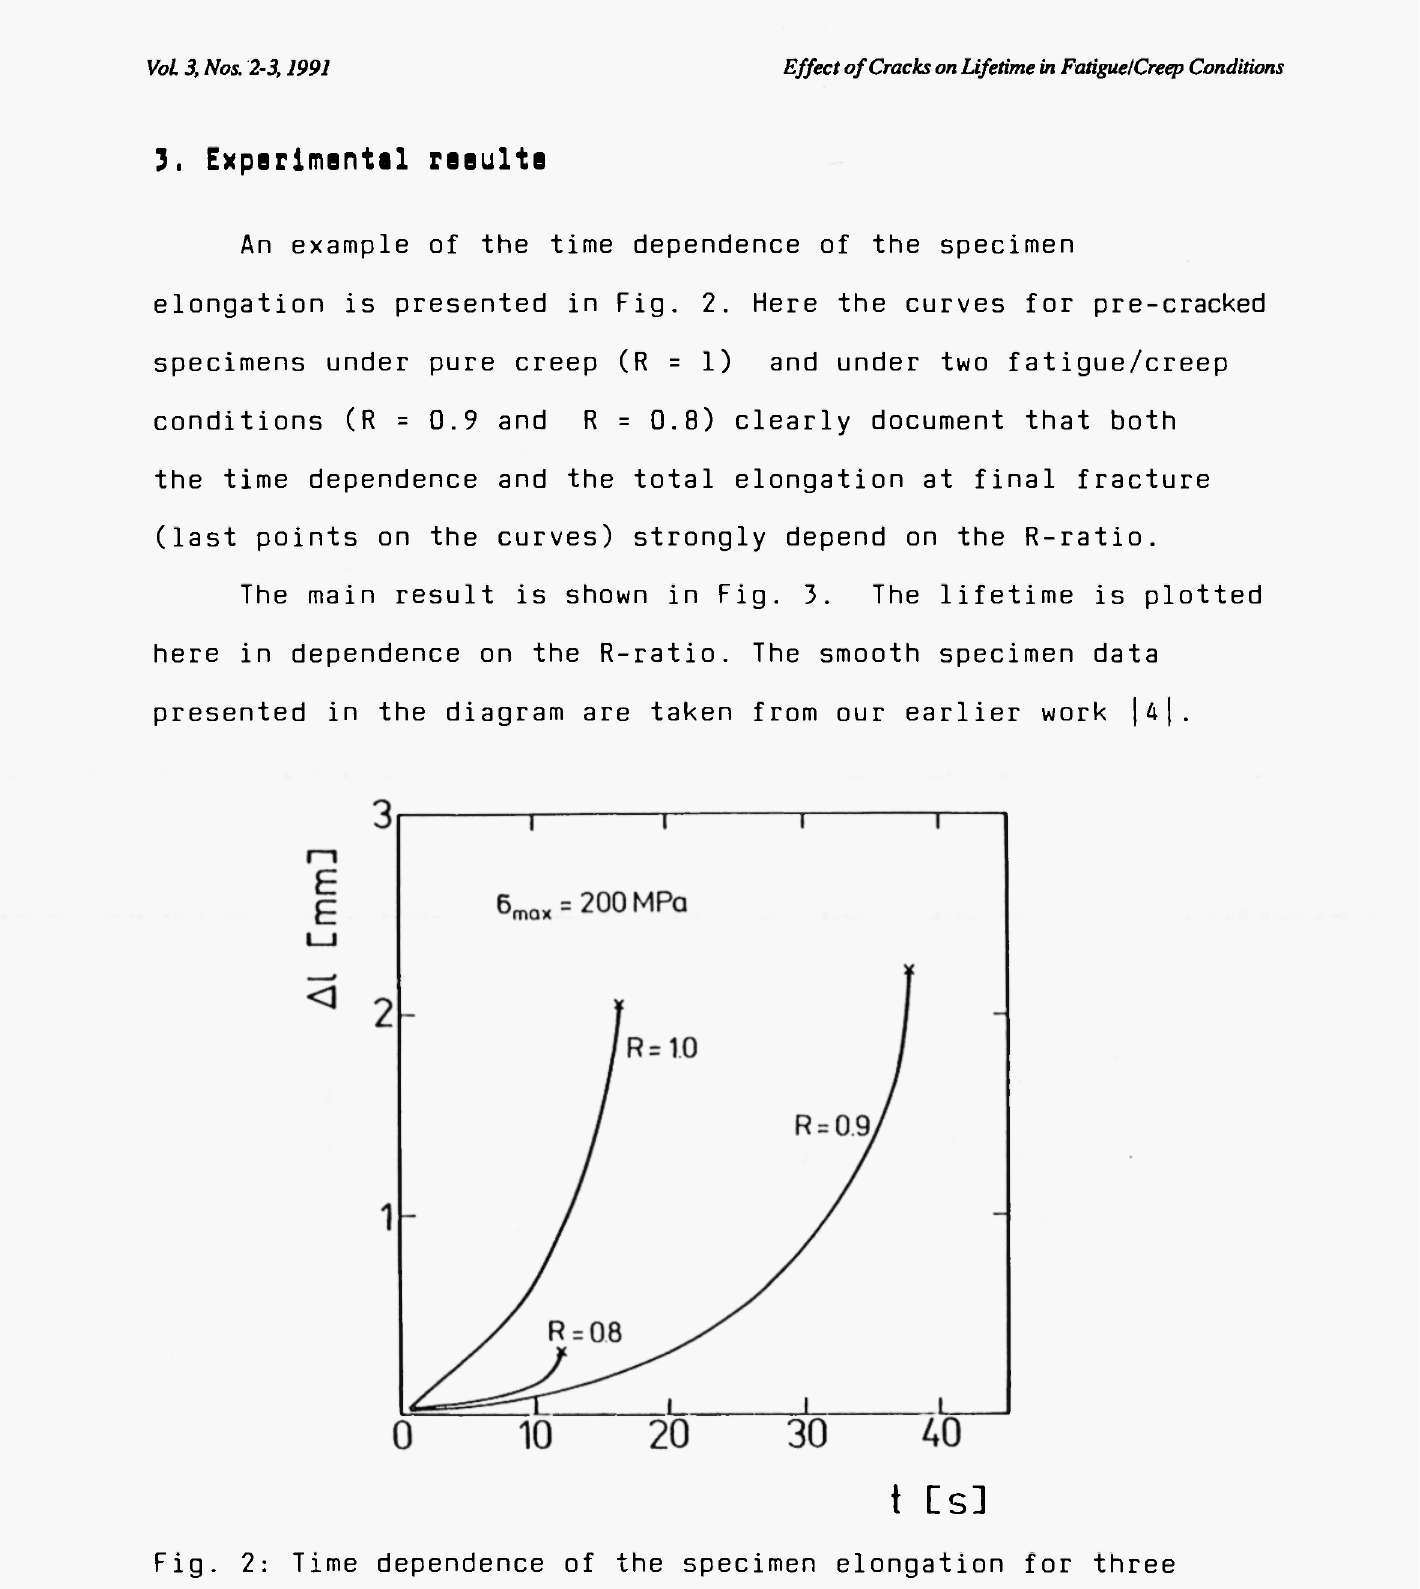
Fig. 2: Time dependence of the specimen elongation for three values of R-ratio. Specimens with the initial crack length 2 £ =4